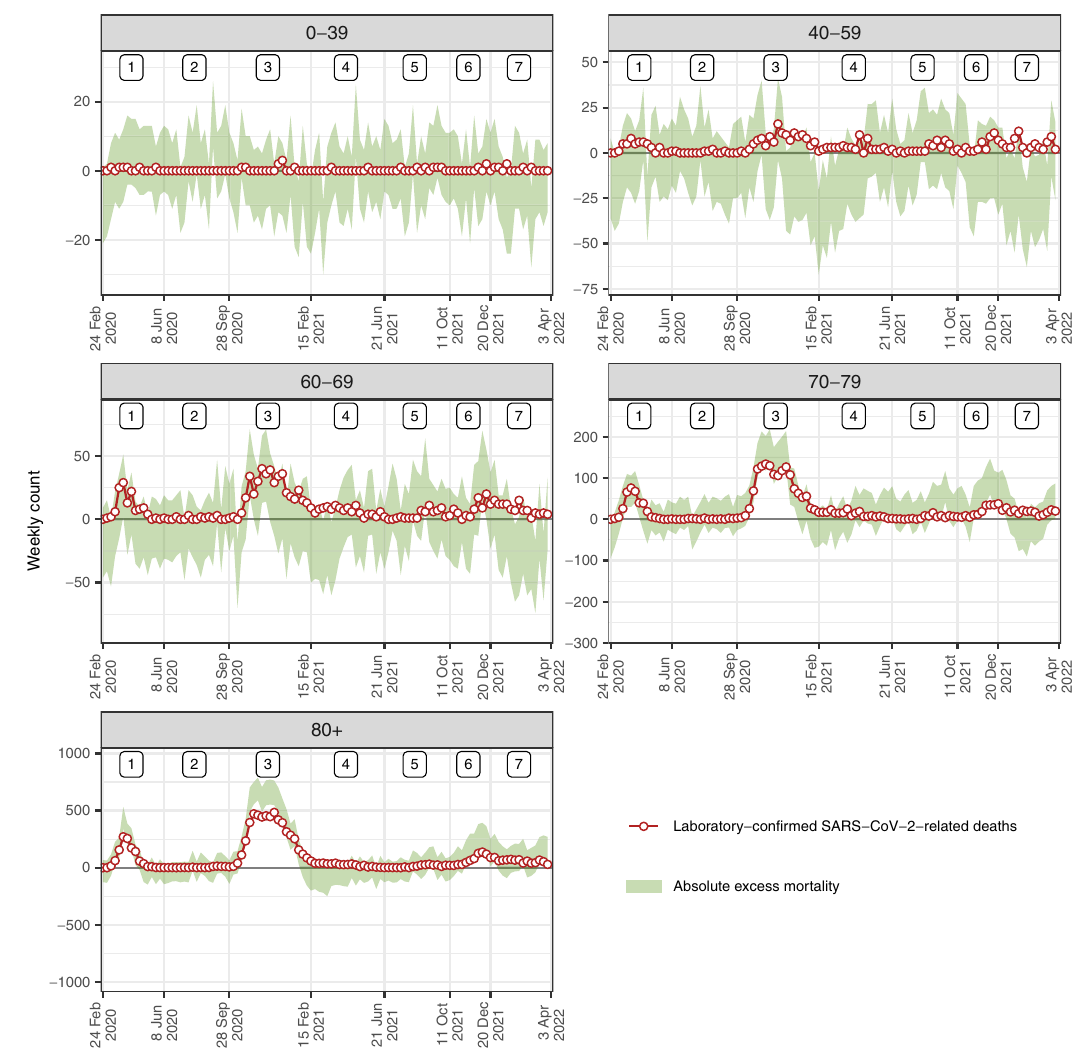
Fig. 2 | Excess all-cause and laboratory-con fi rmed COVID-19-related deaths. Weekly counts of excess all-cause deaths (95% credibility intervals) and of laboratory-con fi rmed COVID-19-related deaths between February 24, 2020 and